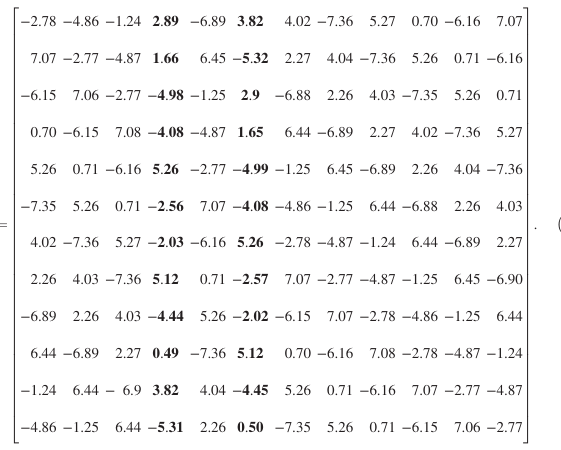
deviation ” on the orbit correction can be quantified in terms of the residual after one iteration of orbit correction,